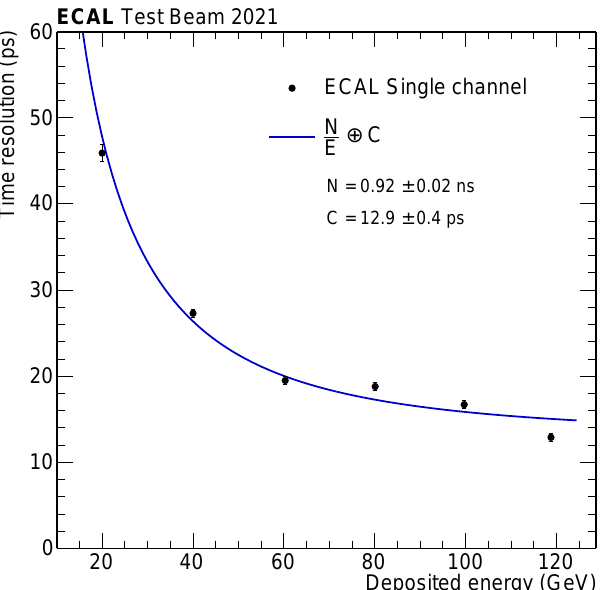
Figure 12. Time resolution as function of the deposited energy obtained in 2021 test beam data. The solid blue line represents the fit with the timing resolution function N / E ⊕ C , where N denotes the noise, C the constant term, and E the deposited energy.